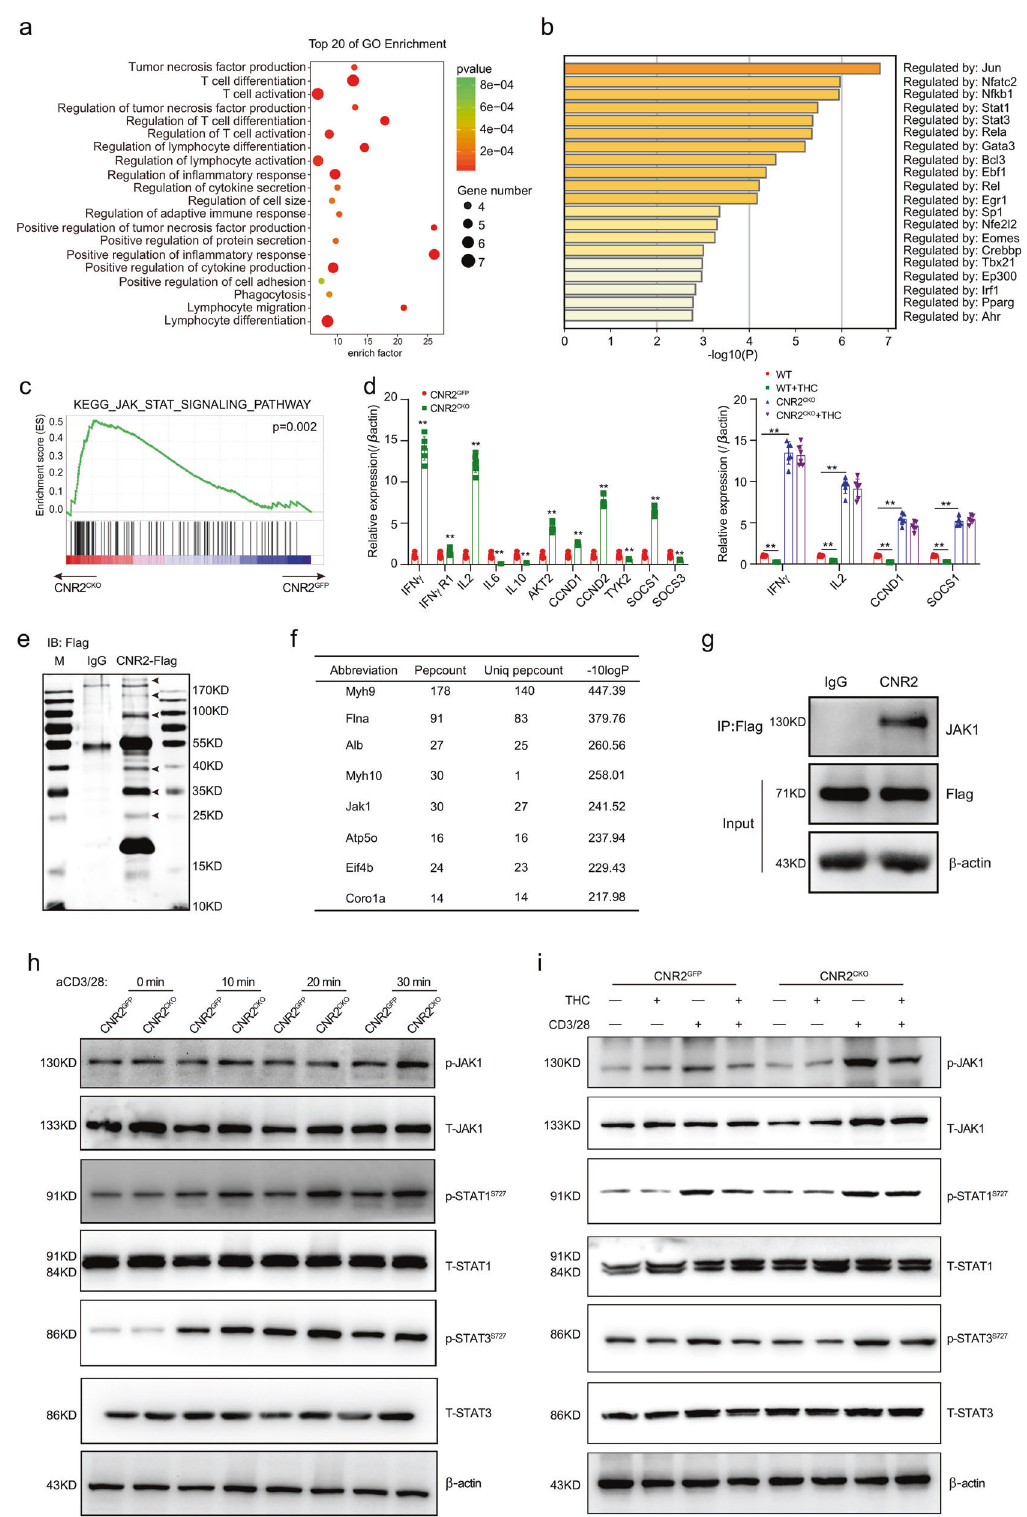
IN) and incubated at 37 °C for 2 h while gently shaking and further processed with the gentleMACS dissociator (Miltenyi Biotech, Bergisch Gladbach, Germany). Digested tumors were then fi ltered through a 70 µm strainer after washed three times with PBS. Spleens and draining lymph nodes were mechanically dissociated Signal Transduction and Targeted Therapy (2022)